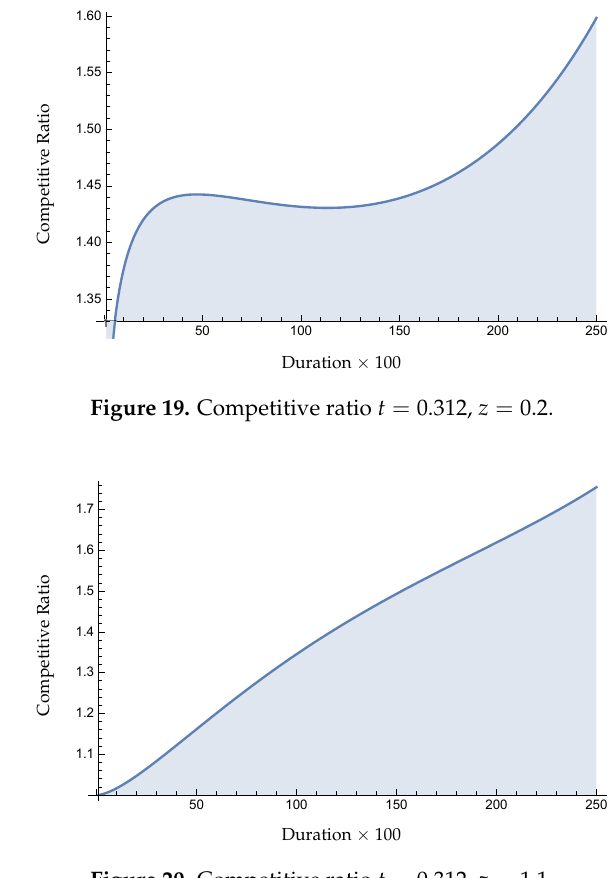
Figure 20. Competitive ratio t = 0.312, z =